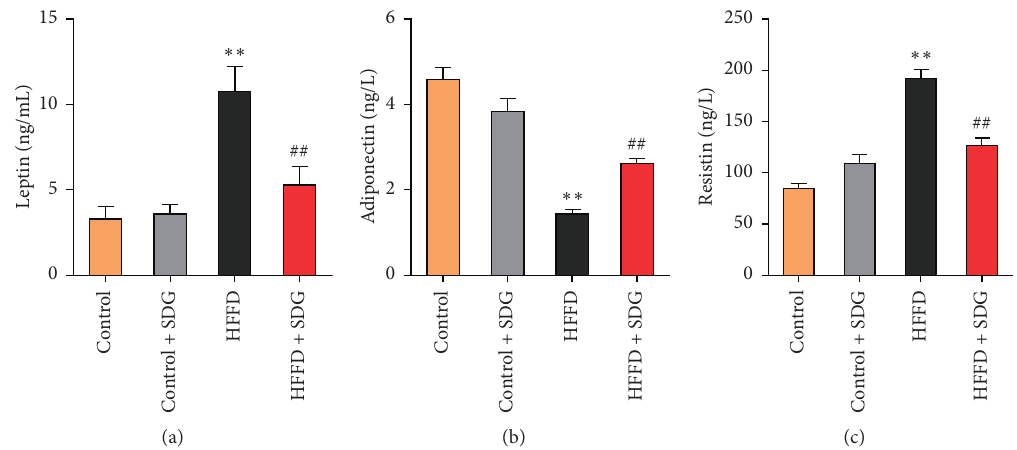
Figure 3: SDG regulates serum adipokines in obese mice induced by a Western diet. (a) Leptin; (b) adiponectin, and (c) resistin. Data are represented as mean ± SEM, n � 10 biologically independent animals. ∗ p < 0 . 05, ∗∗ p < 0 . 01 versus the control group; # p < 0 . 05, ## p < 0 . 01 versus the HFFD